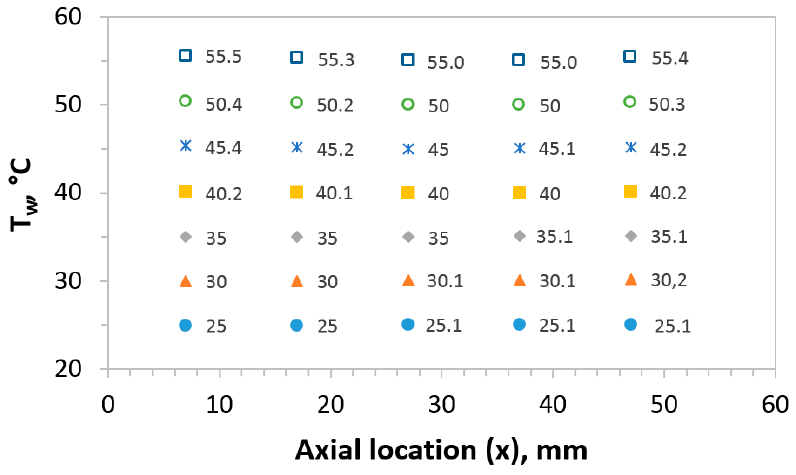
Figure A1. Dependence of the wall temperature on the axial arrangement of thermocouples in the MFHE at zero phase flow.